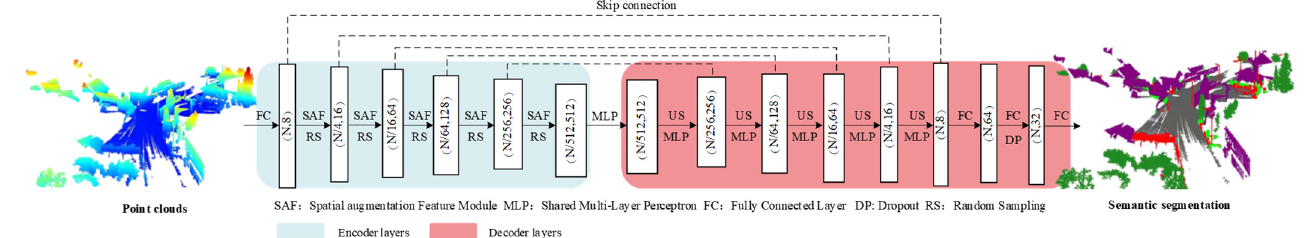
Figure 3. Architecture of improved SCF-Net.